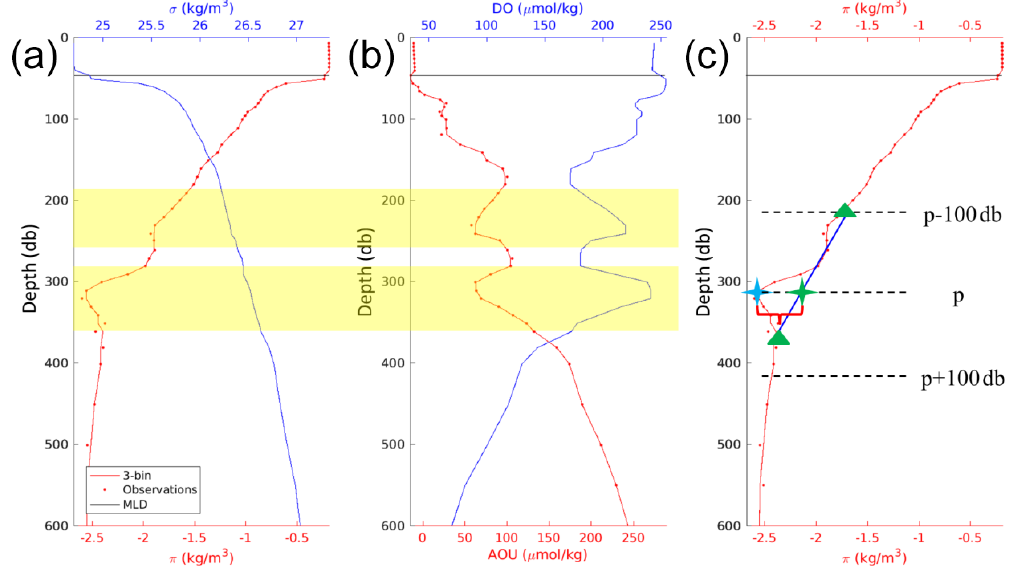
Figure 3. Vertical property distributions of profile no. 234 (on 24 June 2016) of float MD5904034 (the black dot in Fig. 2a) demonstrate subduction patches observed by the BGC-Argo floats. (a) The profiles of potential density ( σ , blue line) and potential spicity ( π , dotted red line), (b) the profiles of DO (blue line) and AOU (red dotted line); (c) the same spicity profile as in (a) , which is used to demonstrate the steps to detect subduction signals described in Methods. Note that the red dots in each panel represent the raw field observations; the overlaid red curves are the three-bin running averages to remove sharp noises or spikes, which are used to calculate the anomalies in AOU and π ; and the black line represents the MLD. The yellow shading in (a) and (b) highlight the subduction features identified using the detection method in (c)